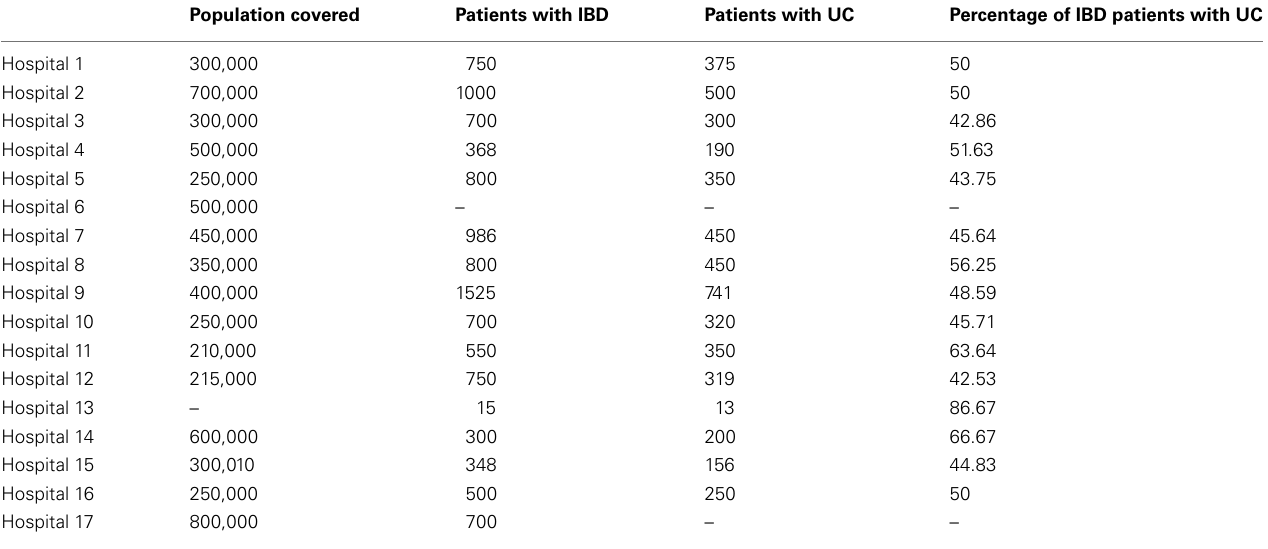
Table 1 | Characteristics of the hospitals that responded to the questionnaire.